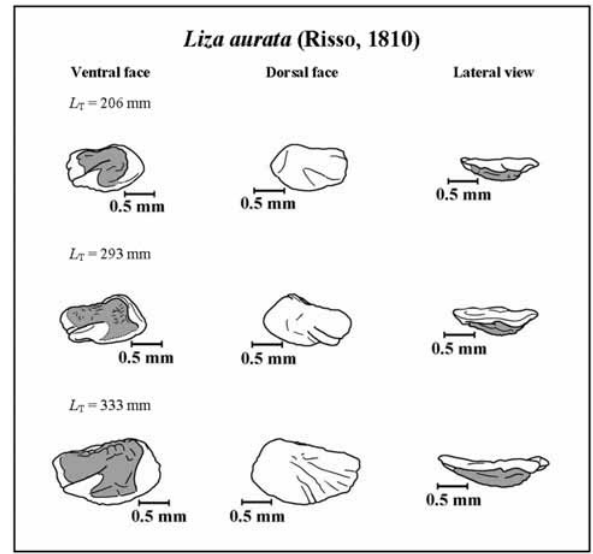
F IG . 13. – Three aspects of a right lapillus from Liza aurata (Mugili- IG . 12. – Three aspects of right lapilli from Chelon labrosus (Mugilidae) of four size classes. The shaded area corresponds to the dae) of three size classes. The shaded area corresponds to the gib- gibbus maculae in the ventral face and lateral view images, and to bus maculae in the ventral face and lateral view images and to the the regio apicale gibbi maculae in those of the dorsal face. The regio apicale gibbi maculae in those of the dorsal face. The otoliths otoliths are represented with the lateral margin to the top of the page are represented with the lateral margin to the top of the page and the and the anterior region to the middle of the first two columns (ven- anterior region to the middle of the first two columns (ventral and tral and dorsal faces), or with the dorsal face to the top of the page dorsal faces), or with the dorsal face to the top of the page and the and the anterior region to the right (lateral view). anterior region to the right (lateral